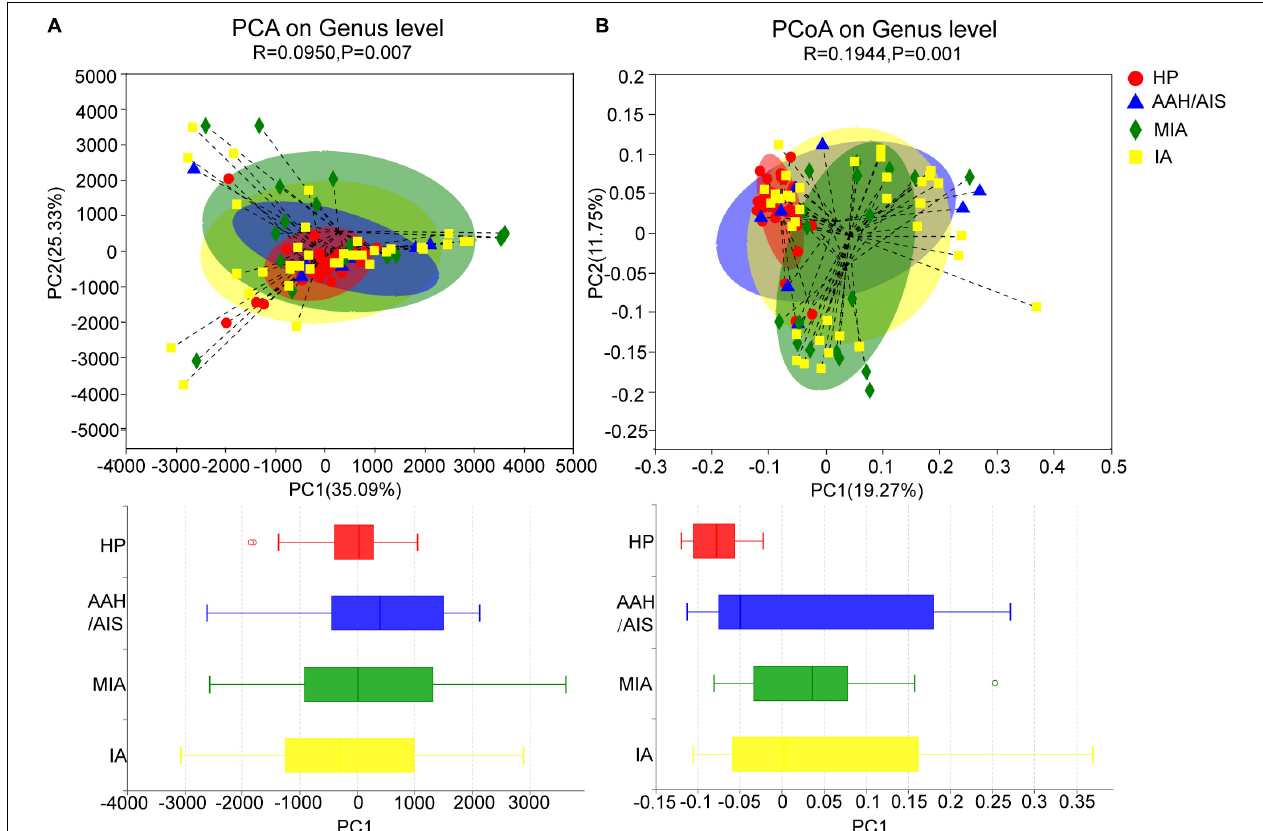
FIGURE 3 | Beta diversity analysis of intestinal flora. (A) PCA analysis of intestinal flora in four groups of samples. (B) PCoA analysis of intestinal flora in four groups of